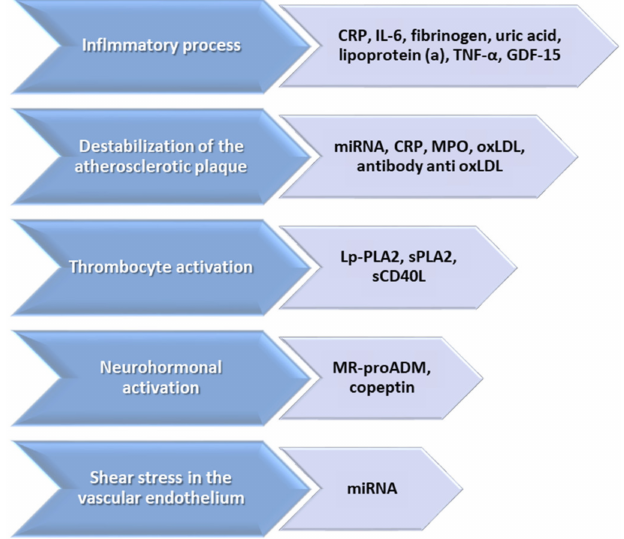
Figure 3. Biomarkers involved in the development and progression of atherosclerotic pro- cess (adapted after [12]) (CRP: C reactive protein; TNF: tumor necrosis factor; GDF-15: growth/differentiation factor-15; MPO: myeloperoxidase; oxLDL: oxidized low-density lipopro- tein; Lp-PLA2: lipoprotein-associated phospholipase A2; Spla2: phospholipase A2; sCD40L: soluble CD40-ligand; MR-proADM: midregional pro-adrenomedullin). Atherosclerosis is known to be a chronic inflammatory process in which interleukin 6 (IL-6), myeloperoxidase (MPO), matrix metalloproteinase 9 (MMP-9), and intercellular and vascular cell adhesion molecules are used as biomarkers. IL-6 and tumor necrosis factor α (TNF- α ) [21] are two proinflammatory cytokines associated with increased car- diovascular risk and atherosclerotic plaque formation [22–24]. In patients with Type 2 diabetes mellitus, increased serum levels of IL-6 are associated with a higher failure rate of interventional revascularization [25]. MPO participates in the oxidation of LDL lipopro- teins (oxLDL) which are highly atherogenic components. In addition to mediating the inflammatory process and destabilizing atherosclerotic plaques, MPO is also involved in of peripheral vascular disease [26]. Intercellular adhesion molecule 1 (ICAM-1) and